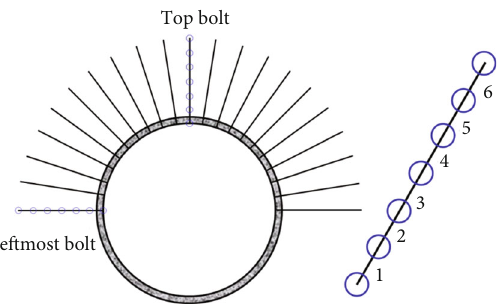
Figure 3: Tunnel bolt monitoring position and bolt monitoring point